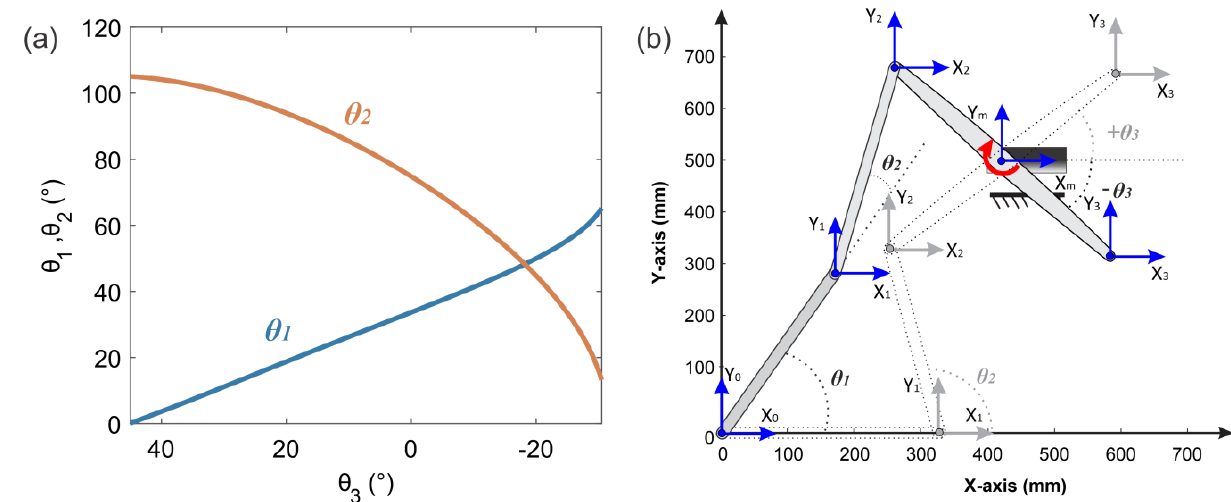
Figure 7. Kinematic ankle dorsiflexion rehabilitation movement simulation. ( a ) angular positions θ 1 and θ 2 with respect to θ 3 , ( b ) two–dimensional graphical representation.